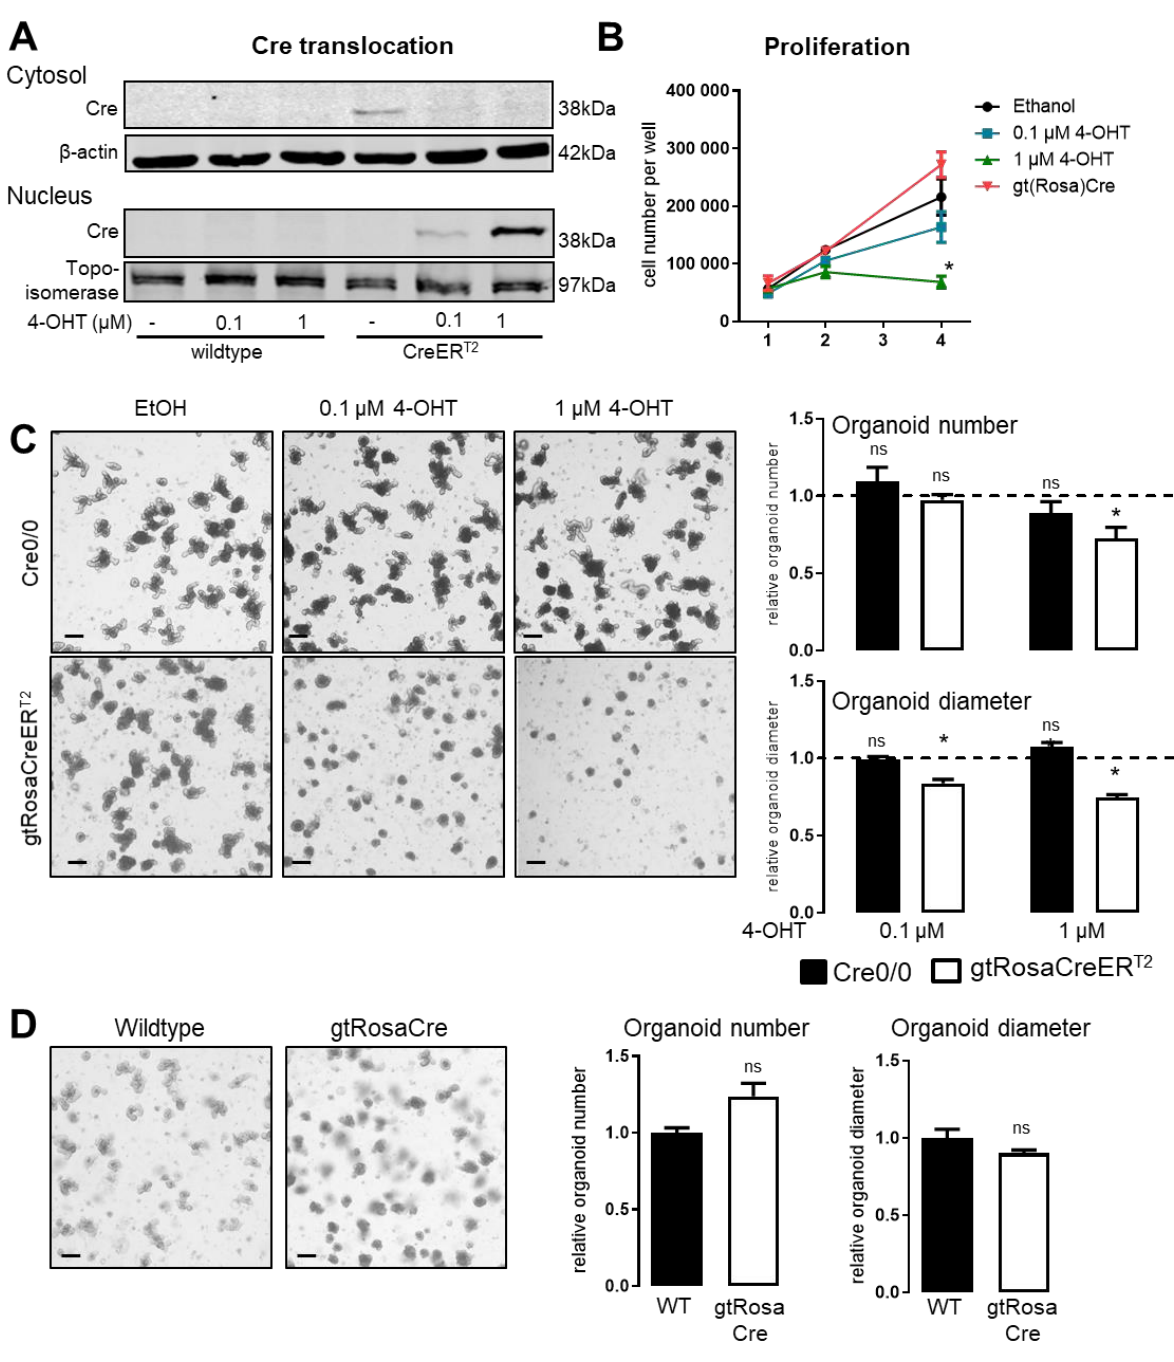
( Figure 1C ). In contrast, number and diameter of gtRosaCre-organoids with constitutive active Cre-recombinase did not differ from the corresponding wildtype ( Figure 1D ).